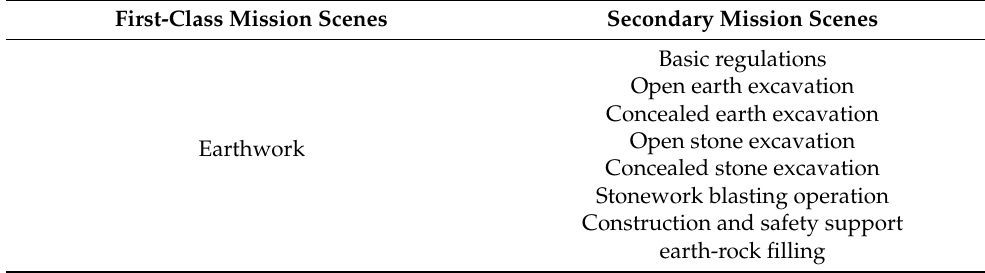
Table 1. Task scenario